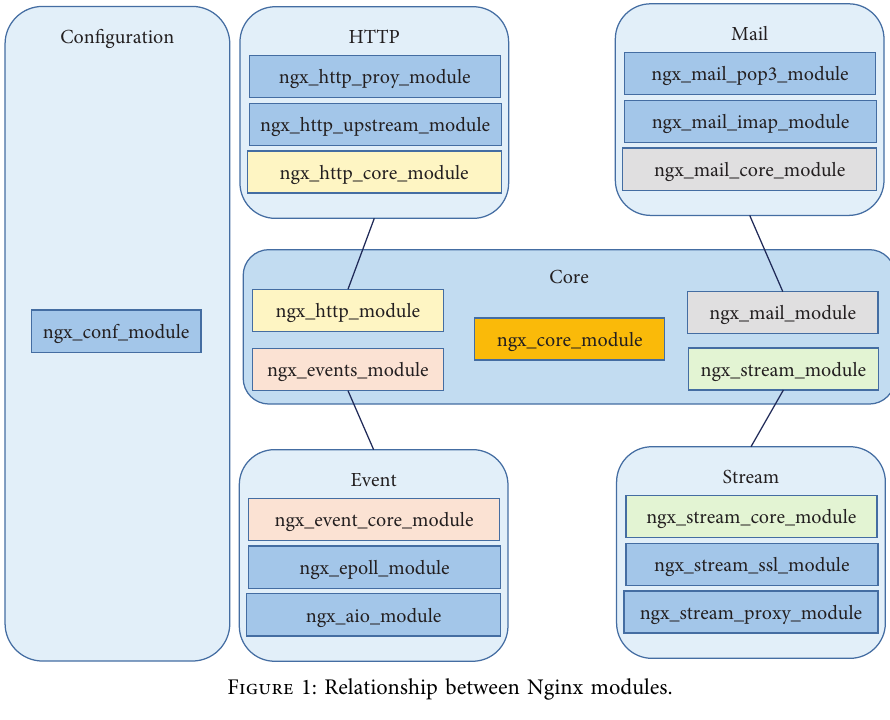
Figure 1: Relationship between Nginx modules.